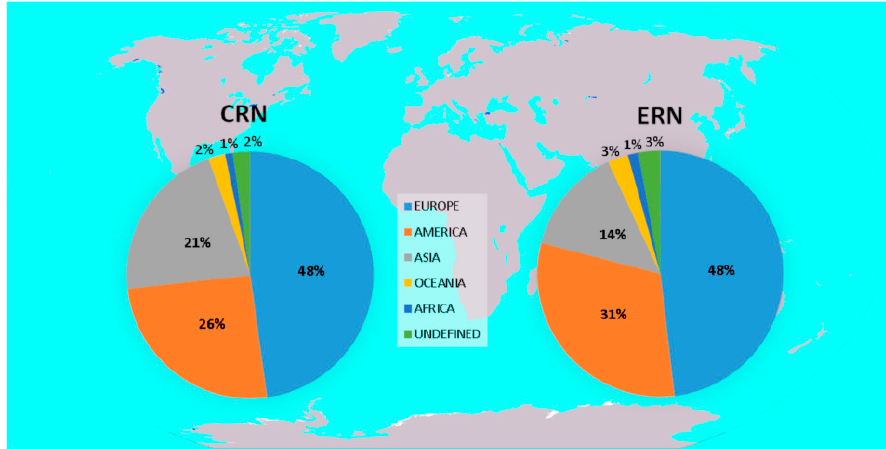
Figure 6. Graphical representation of the worldwide contribution to publications discussing CRNs and ERNs.